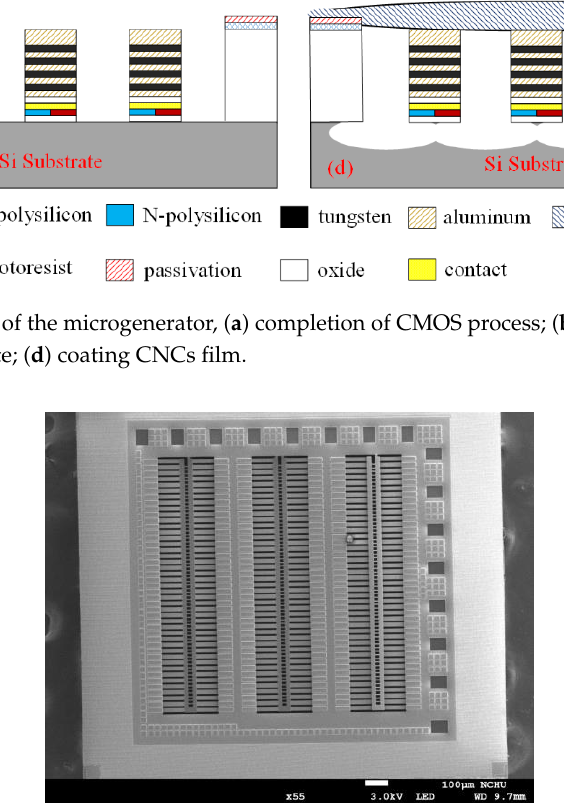
Figure 9. SEM picture of the microgenerator post-CMOS processing.